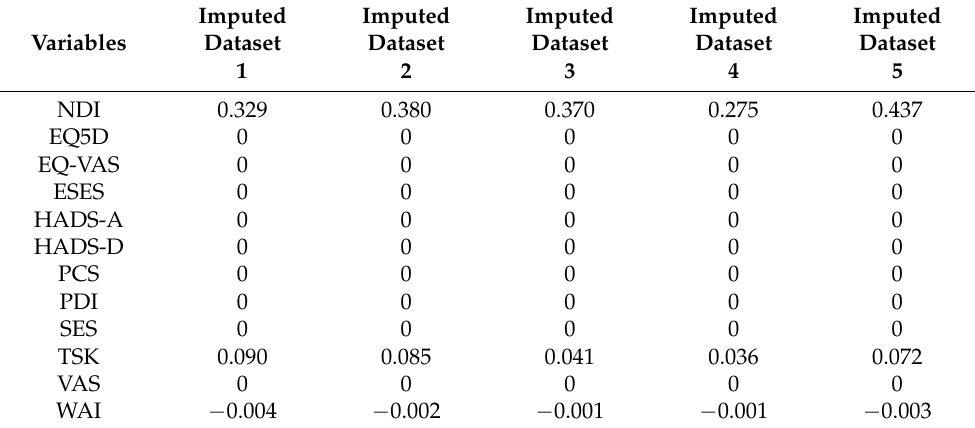
Table 3. Selected predictor variables for response variable of NDI at 2 years.